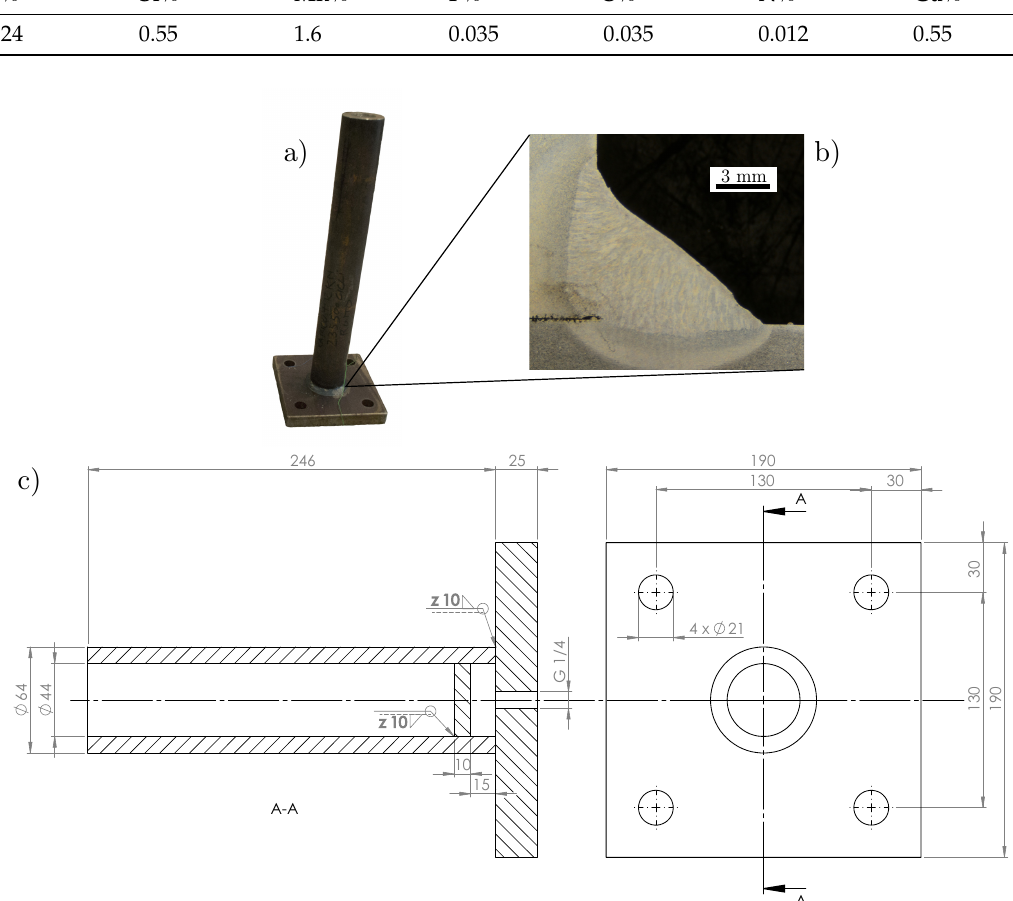
Figure 1. Real sample ( a ), micrograph of the weld seam ( b ), technical drawing of the specimen ( c